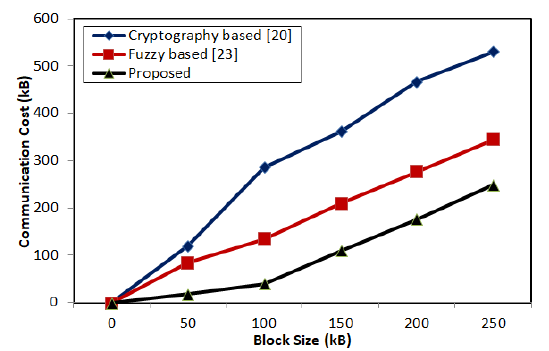
Figure 4. Communication cost w.r.t block size